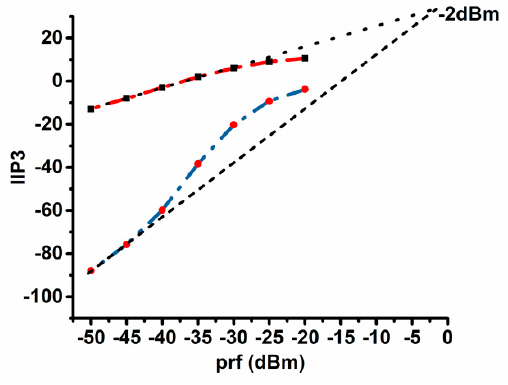
Figure 19. The measured IIP3.